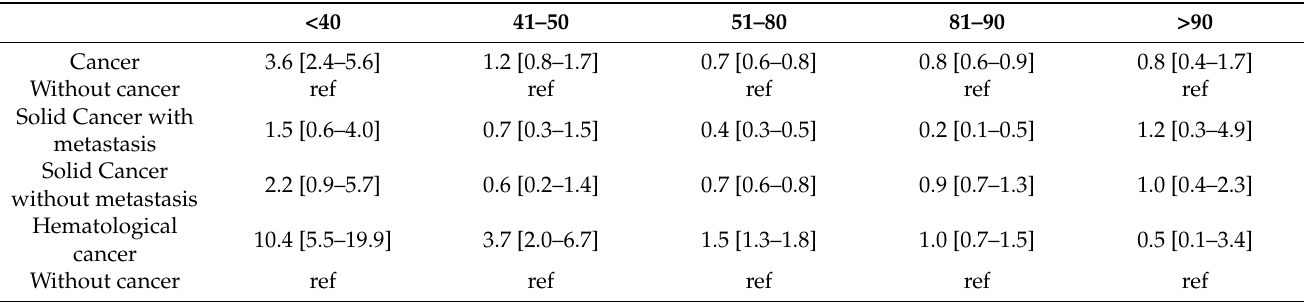
Table 3. Logistic regression to study the risk of transfer to intensive care unit (adjusted odds ratio) regarding patients hospitalized in France for COVID-19 (from 1 March 2020, to 30 April 2020) with cancer or not.